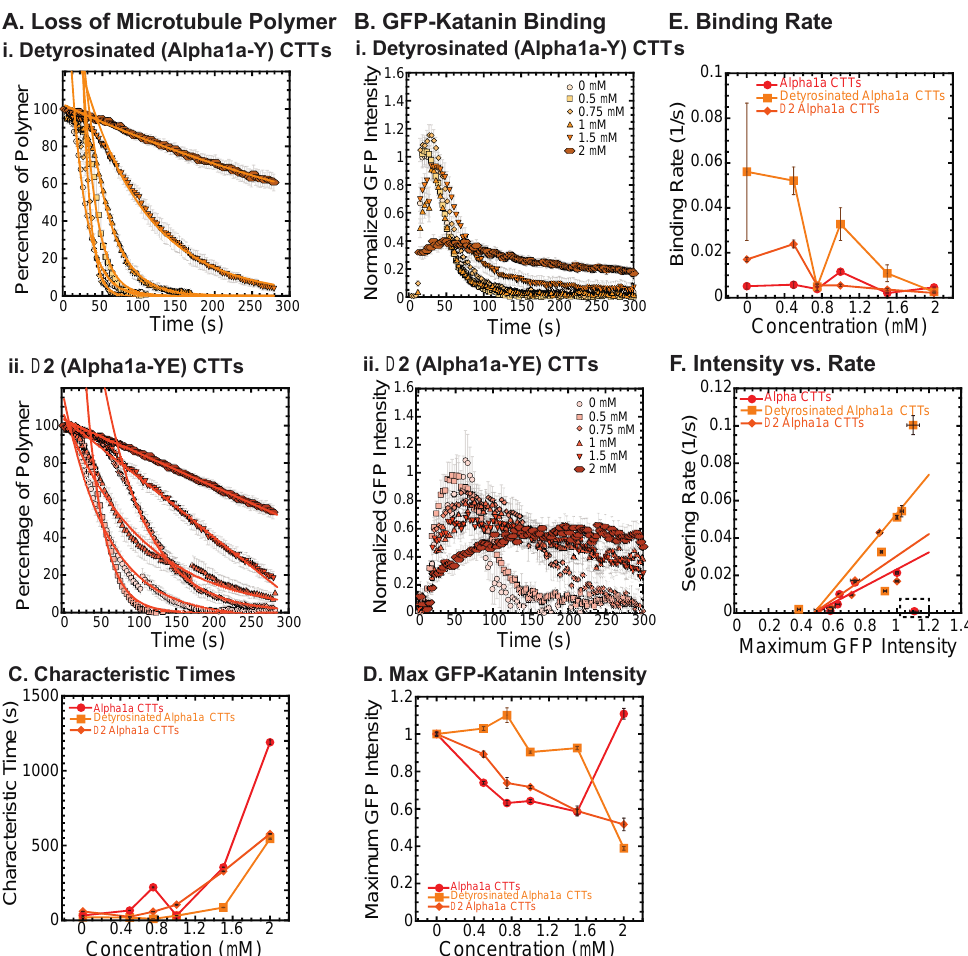
Figure 3. Effects of alpha1a CTT post-translational modifications on katanin inhibition. ( A ) Loss of polymer caused by increasing concentration of ( i ) detyrosinated alpha1a CTTs (light orange) and ( ii ) ∆ 2 alpha1a CTTs (dark orange). The transition from exponential decay to linear decay is observed for loss of polymer data as it goes from no inhibitor (0 µ M, lightest shade circles), low inhibitor (0.5 µ M, light shade squares; 0.75 µ M, light shade diamonds), medium inhibitor (1 µ M, medium shade triangles with point up), to highest inhibitor (1.5 µ M, darker shade triangles with point down, 2 µ M, darkest shade hexagons). Each dataset is fit with a best fit equation to an exponential or linear decay with best fit parameters provided in Supplemental Information Table S4. ( B ) The data for the GFP-katanin binding by increasing concentration of ( i ) detyrosinated alpha1a CTTs (light orange) and ( ii ) ∆ 2 alpha1a CTTs (dark orange). The data were normalized by the maximum when there was no inhibitor (0 µ M, lightest shade circles). Data for low inhibitor (0.5 µ M, light shade squares; 0.75 µ M, light shade diamonds), medium inhibitor (1 µ M, medium shade triangles with point up), to highest inhibitor (1.5 µ M, darker shade triangles with point down, 2 µ M, darkest shade hexagons) are shown. ( C ) The characteristic decay times for loss of polymer as a function of concentration for alpha1a CTTs (red circles), detyrosinated alpha1a CTTs (light orange squares) and ∆ 2 alpha1a CTTs (dark orange diamonds). Error bars represent the uncertainty in the fit parameters. ( D ) The average normalized maximum for GFP-katanin binding to microtubules for alpha1a CTTs (red circles), detyrosinated alpha1a CTTs (light orange squares) and ∆ 2 alpha1a CTTs (dark orange diamonds). Error bars represent the standard deviation of the average. ( E ) GFP-katanin binding was measured for the initial time points for each data set by fitting a linear fit equation from the initial times to the time when maximum is reached. The slopes of the fits represent the rate of katanin binding, plotted as a function of CTT concentration for alpha1a CTTs (red circles), detyrosinated alpha1a CTTs (light orange squares) and ∆ 2 alpha1a CTTs (dark orange diamonds). Error bars represent the